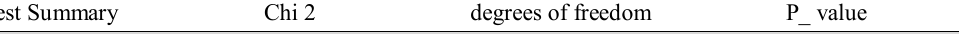
Results of Housman test